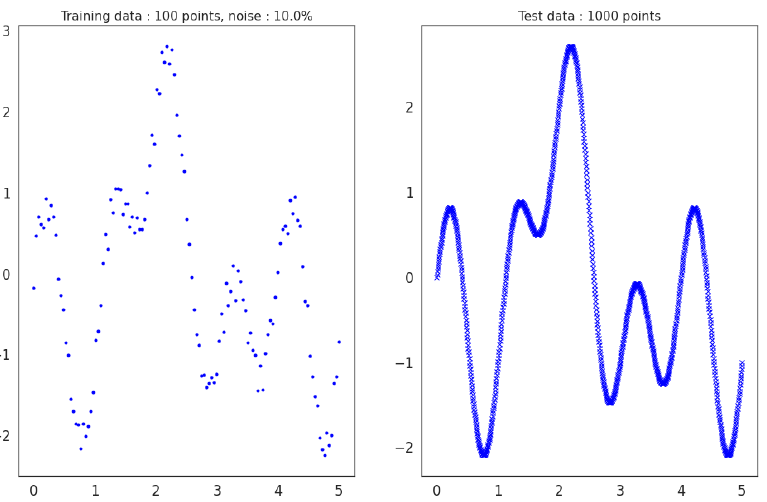
Figure 3. Training scenario with noise p = 10% and N = 100 training data points. Data is sampled linearly from f ∗ in the [ 0,5 ] range, and then the noise is added. Training noisy data is on the left, 1 while noiseless test data is on the